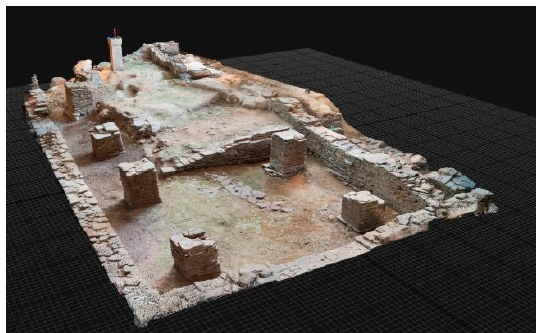
Figure 1. Optimized Model. 10.2 M triqs